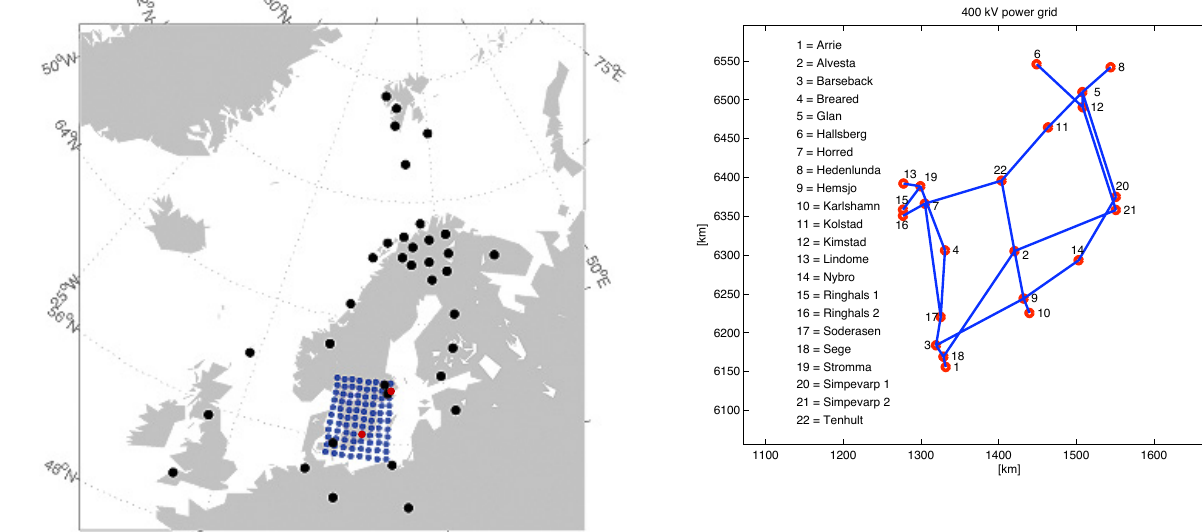
Fig. 2. Southern Swedish 400 kV electric power transmission grid. The transmission lines shown in blue colour are approximated to be